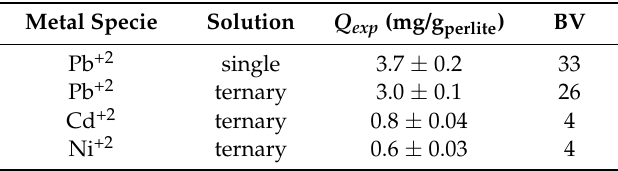
Table 3. Summary of the column tests carried out on perlite and operative breakthrough parameters